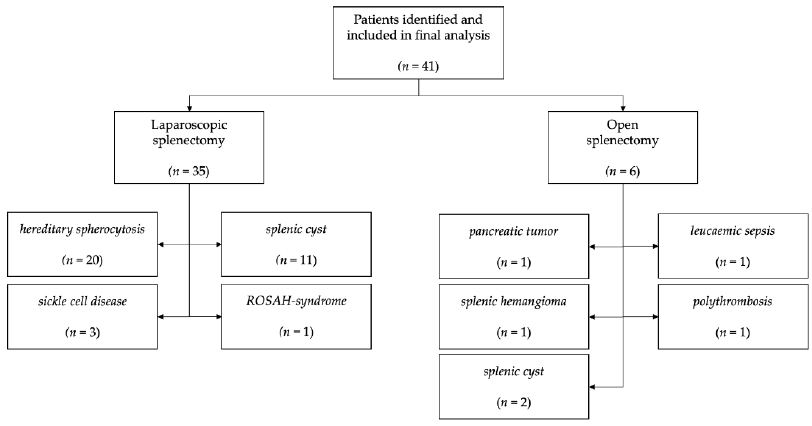
Figure 1. Patients that were operated and included in the study. Table 1. Patient characteristics (total n = 41).